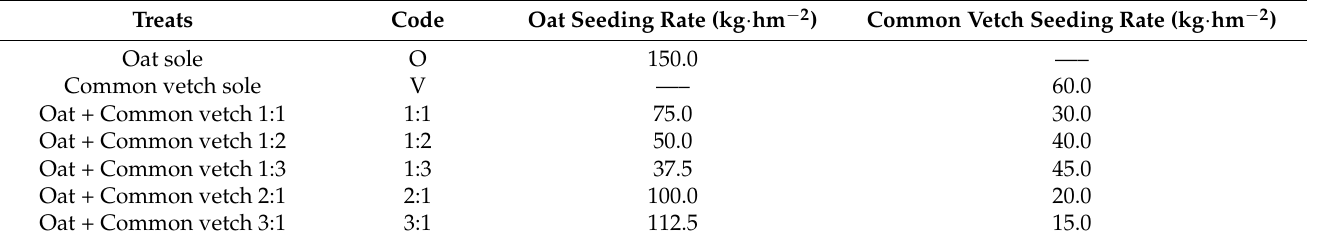
Table 2. The experiment